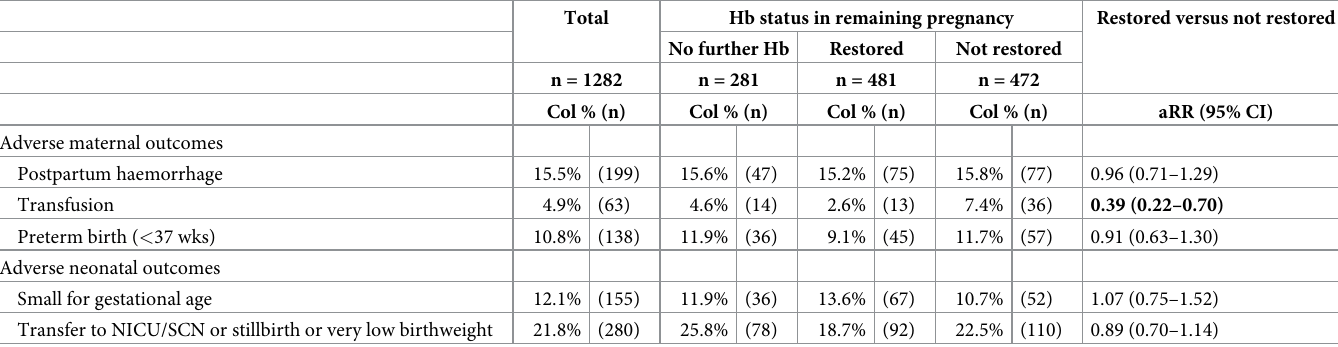
Table 3. Outcomes among those with low Hb at 20 weeks gestation or less, by Hb status in the remaining weeks. Total Hb status in remaining pregnancy Restored versus not